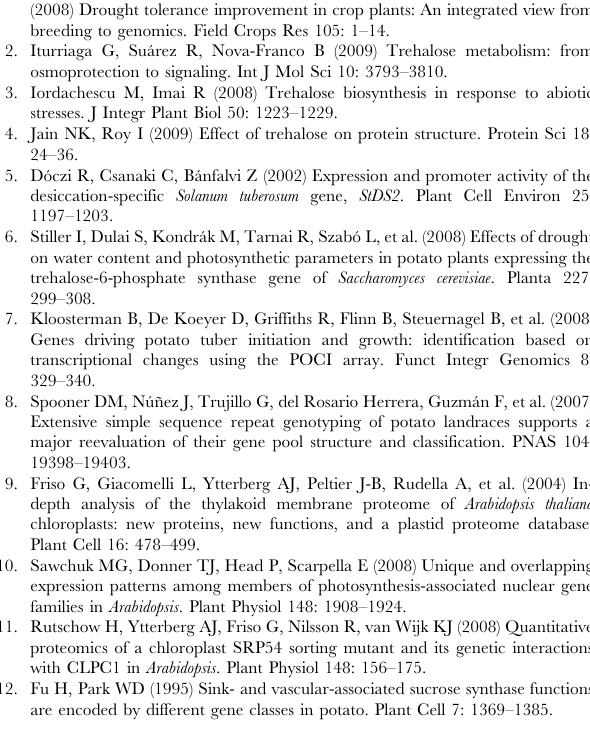
Table S3 Transcription factors binding to the promoter region of putative Arabidopsis orthologs of differentially expressed potato genes. Table S4 Transcription factor binding sites in the promoter region of putative Arabidopsis orthologs of differentially expressed potato genes. Table S5 Protein-protein interactions involving puta- tive Arabidopsis orthologs of potato proteins encoded by assigned genes in microarray experiments. Table S6 PCR primers used to amplify cDNA fragments to generate hybridisation probes for verification of the microarray